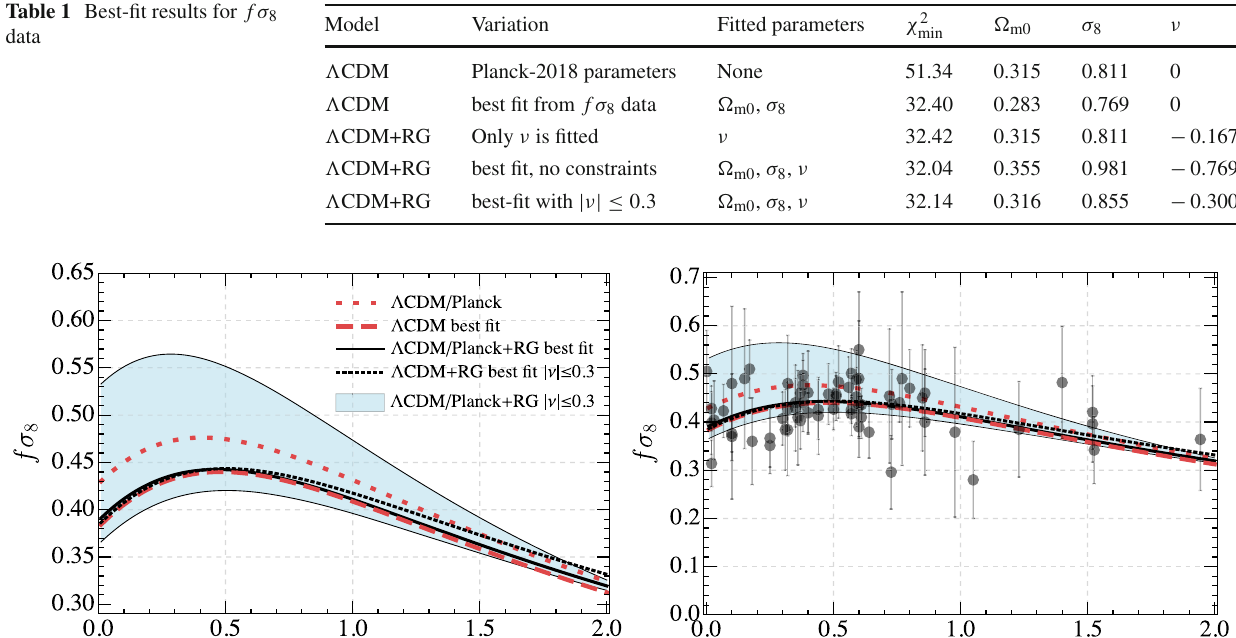
Fig. 1 f σ 8 model comparison. Left: f σ 8 curves for four models that appear in Table 1, only the best fit model without constraints is not shown (since it violates the bound (94), and since its curve is similar to the dotted black curve). (cid:4) CDM/Planck means that the parameters (cid:24) σ m0 and 8 are those given by the 2018 Planck collaboration [55]. The